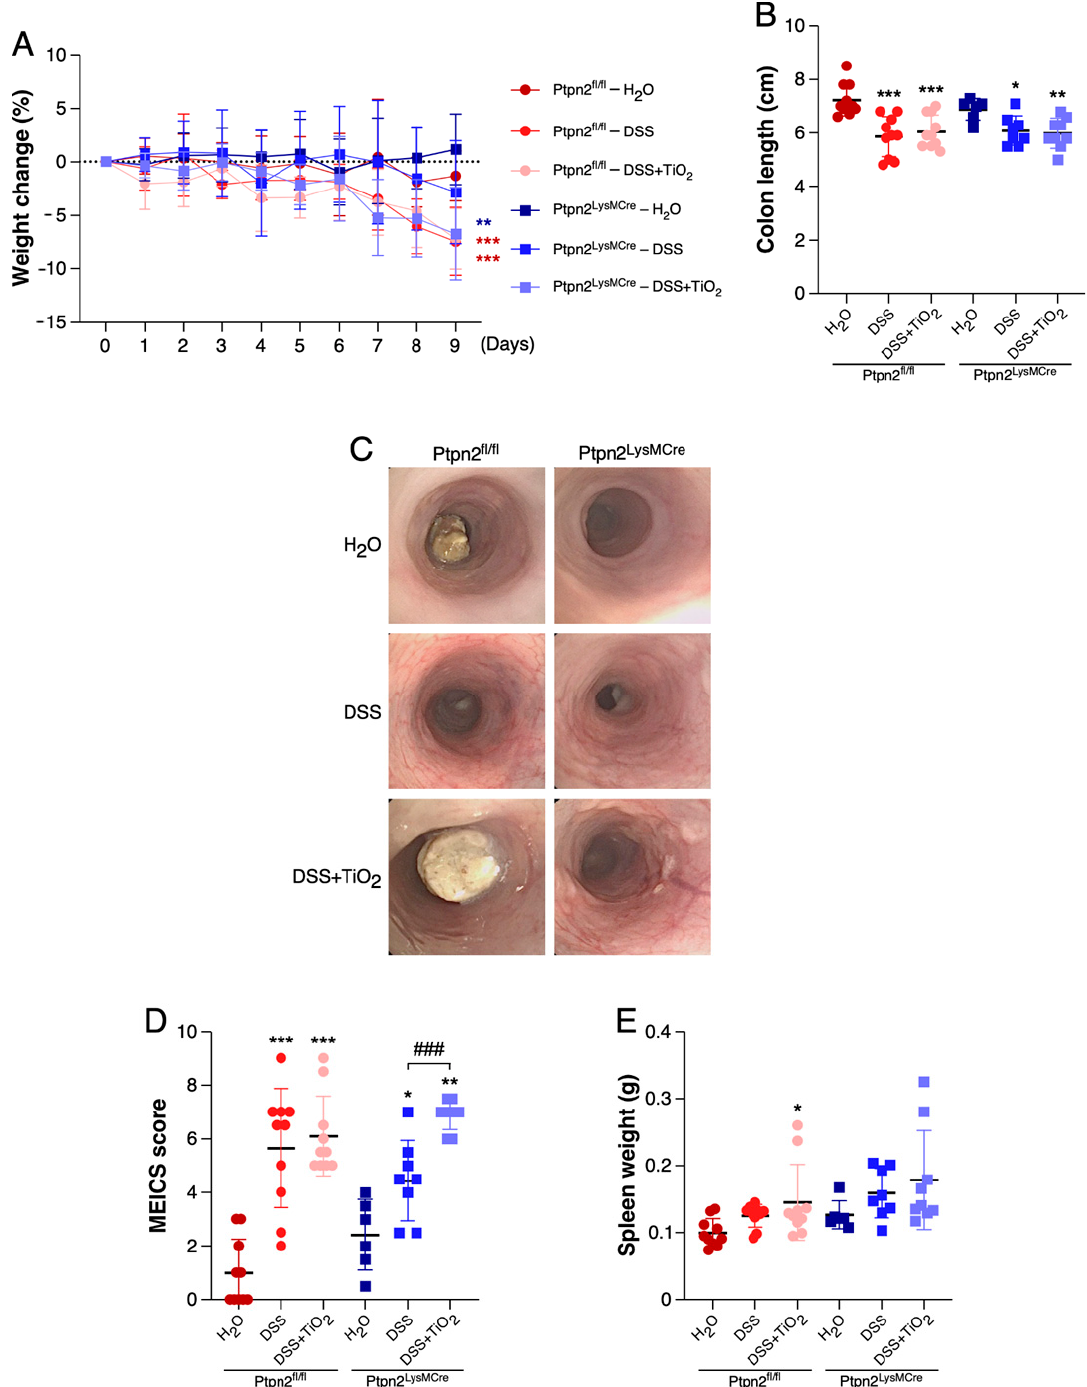
Figure 1. Loss of Ptpn2 in myeloid cells exacerbates TiO 2 effects at endoscopic level. ( A ) Percentage of weight change in Ptpn2 fl/fl and Ptpn2 LysMCre mice during DSS-acute colitis under the indicated treatments. ( B ) Representation of the colon length in Ptpn2 fl/fl and Ptpn2 LysMCre mice during DSS-acute colitis under the indicated treatments. ( C ) Representative endoscopic images of Ptpn2 fl/fl and Ptpn2 LysMCre mice during DSS-acute colitis under the indicated treatments. ( D ) Endoscopy scoring using the murine endoscopic index of colitis severity (MEICS) of Ptpn2 fl/fl and Ptpn2 LysMCre mice during DSS-acute colitis under the indicated treatments. ( E ) Representation of the spleen weight in Ptpn2 fl/fl and Ptpn2 LysMCre mice during DSS- acute colitis under the indicated treatments. Data shown in panels ( A,B,D,E ) represent mean ± SD. * p ≤ 0.05; ** p ≤ 0.01; *** p ≤ 0.001 relative to H 2 O of the same genotype. ### p ≤ 0.001 relative to DSS of the same